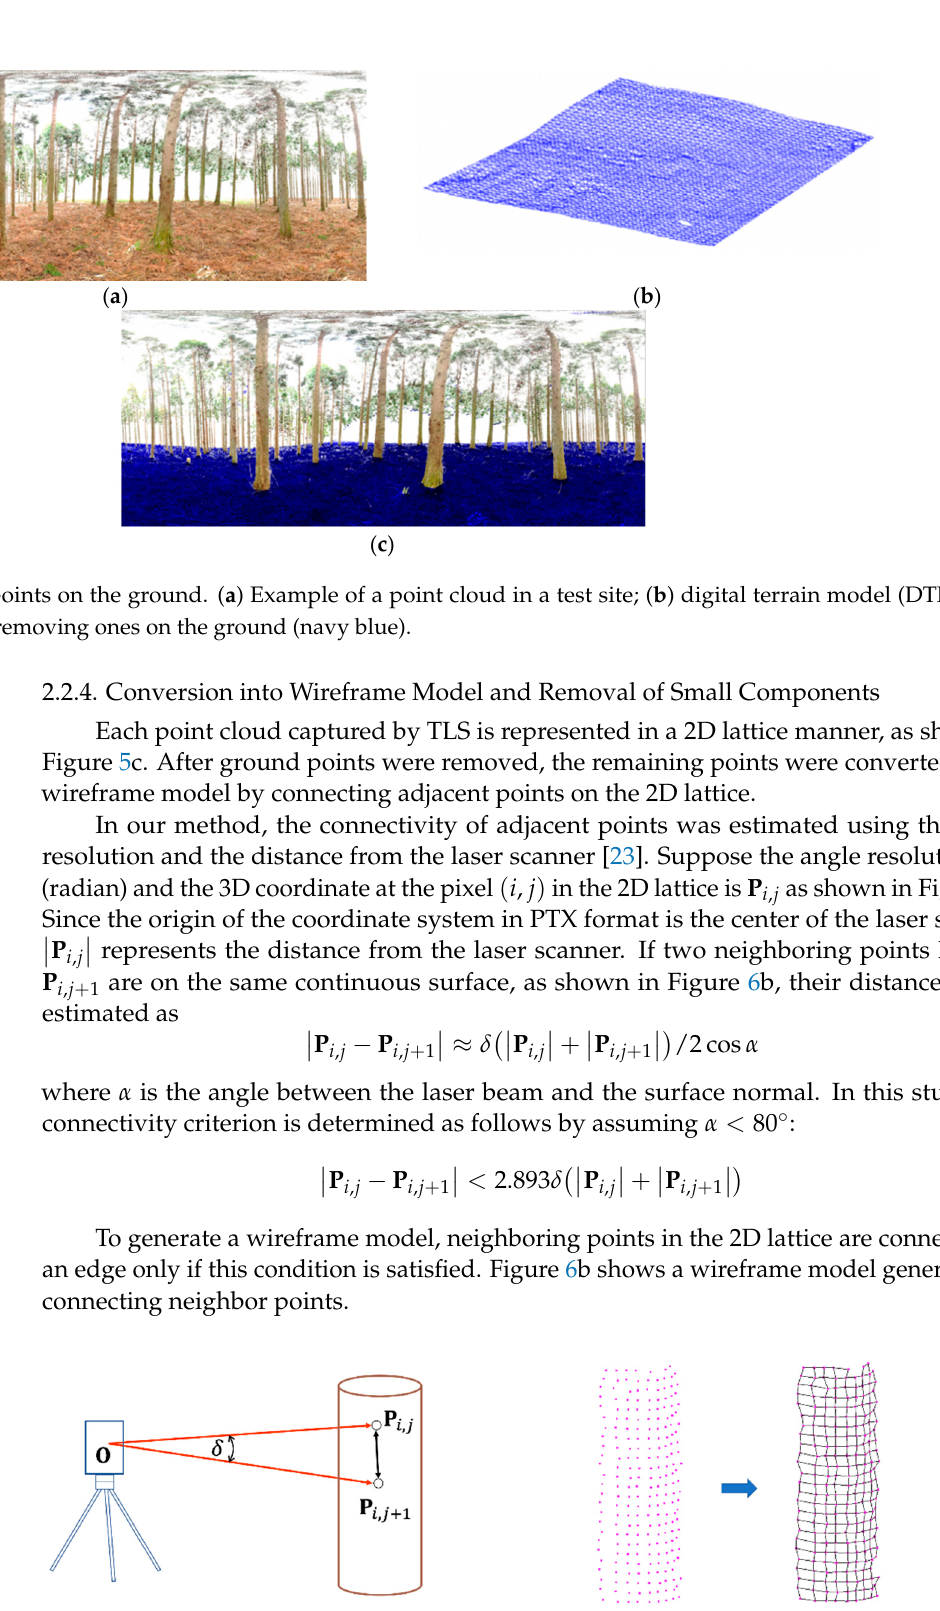
( b ) Figure 7. Segmentation into connected regions. ( a ) Connected regions; ( b ) removal of small re- gions. 2.2.5. Cross-Sectional Points on Horizontal Planes Cross-sectional points are calculated as the intersection points between the wireframe model and horizontal planes. In this section, we assume that the coordinates of points are registered coordinates defined in the global coordinate system. Suppose that horizontal planes are placed at the equal interval (cid:1871) , as shown in Figure 8a. The equation of each horizontal plane is represented as (cid:1878) (cid:3404) (cid:1863)(cid:1871) using a layer index (cid:1863) . Then, the area between (cid:1878) (cid:3404) (cid:1863)(cid:1871) and (cid:1878) (cid:3404) (cid:4666)(cid:1863) (cid:3397) 1(cid:4667)(cid:1871) is denoted as the layer (cid:1863). Cross-sectional points can be efficiently calculated in an out-of-core manner. Suppose that the registered coordinates (cid:1790) (cid:3036),(cid:3037) and (cid:1790) (cid:3036),(cid:3037)(cid:2878)(cid:2869) are connected by an edge and located in the layer (cid:1865) and layer (cid:1866) , respectively. Then, the edge between (cid:1790) (cid:3036),(cid:3037) and (cid:1790) (cid:3036),(cid:3037)(cid:2878)(cid:2869) intersects with horizontal planes between (cid:1865) and (cid:1866) . In Figure 8b, intersection points with horizon- tal planes are shown in white circles. Figure 8c shows the calculated cross-sectional points. The section points are maintained on each horizontal plane. Once cross-sectional points are calculated from all edges in a wireframe model, the wireframe model is then deleted from the RAM, and the next point clouds are loaded. Section points calculated from each point cloud are merged on horizontal planes, as shown in Figure 9. ( a ) ( c ) Figure 8. Section points between a wireframe model and horizontal planes. ( a ) Horizontal planes; ( b ) intersections (white circle); ( c ) section points.